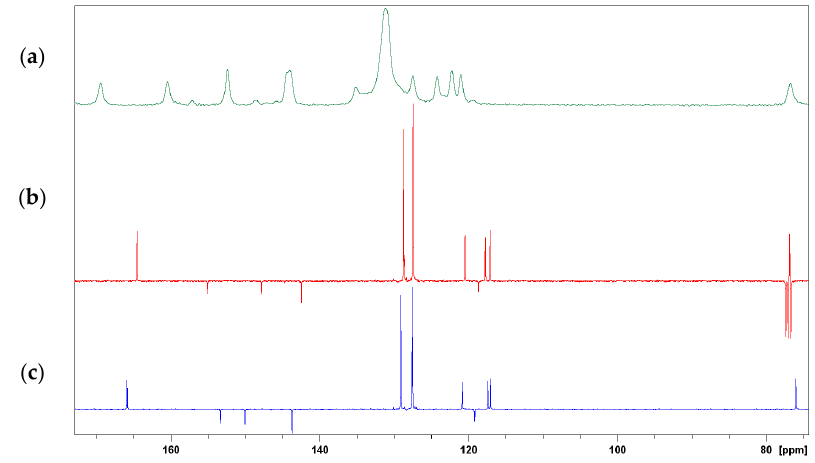
Figure D7. A comparison of solid state 13 C CP-MAS spectrum of pOHsaladpm ( a ) with solution state